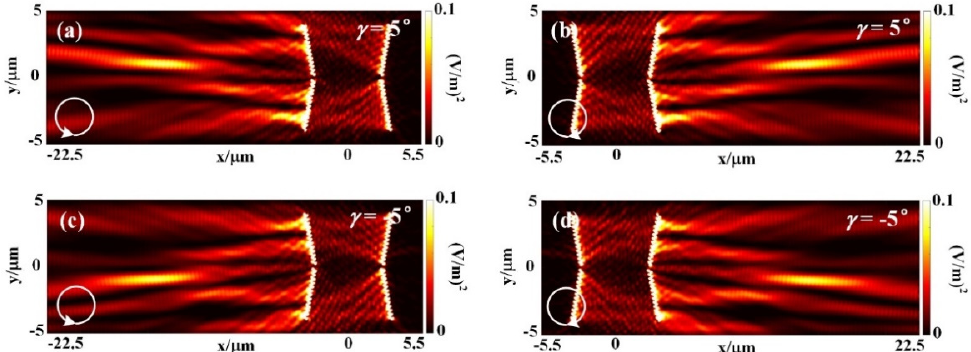
Figure 4. ( a , b ) The nondiffracting SPP-beam intensity distribution under inclined angle γ = 5 ◦ when the incident light is LCP and RCP, respectively. ( c , d ) The nondiffracting SPP-beam intensity distribution under inclined angle γ = − 5 ◦ when the incident light is LCP and RCP, respectively.